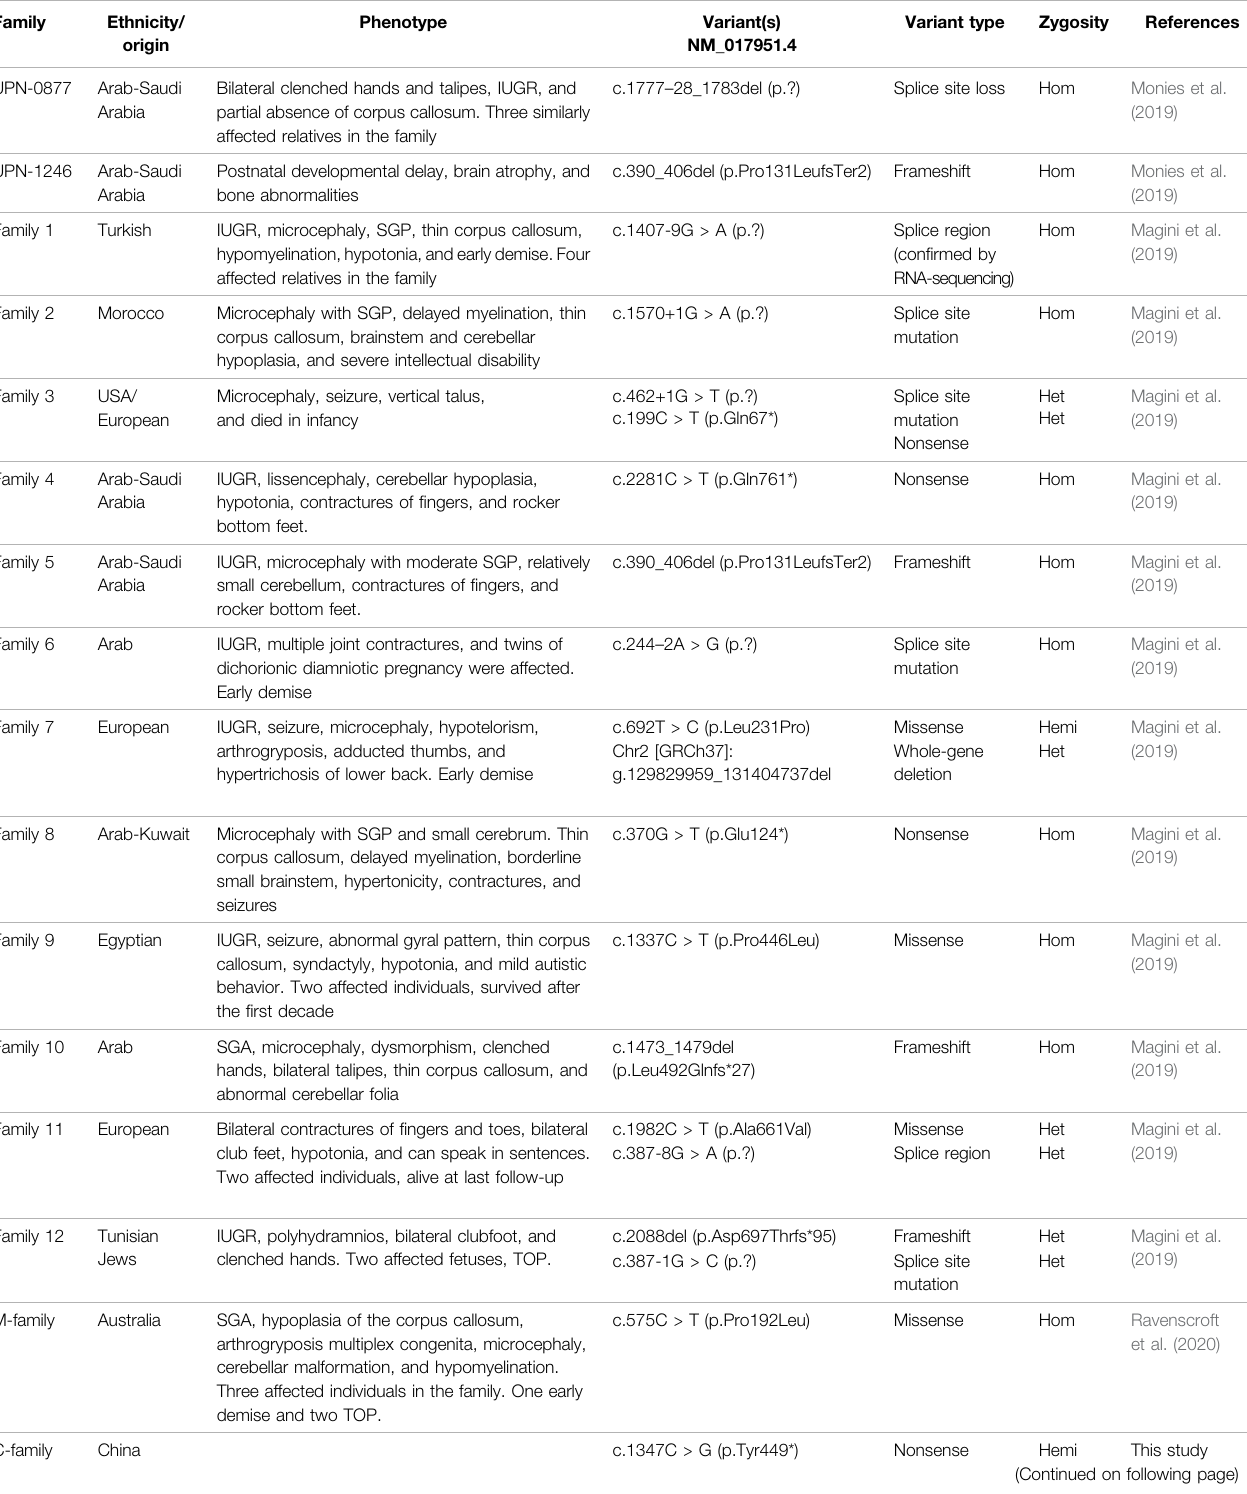
TABLE 1 | SMPD4 variants and affected